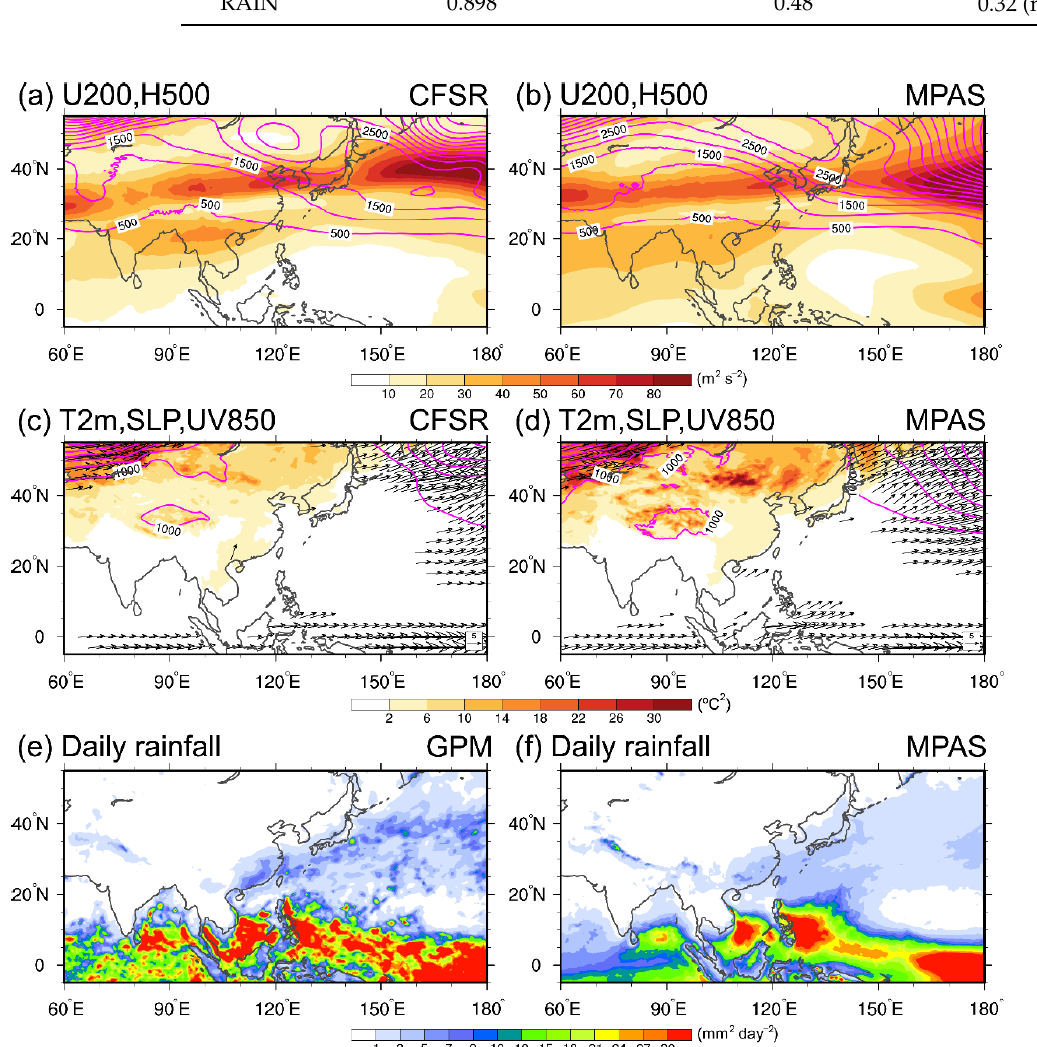
Figure 3. Same as Figure 2 but for the interannual DJF variances over 2011 – 2020 for ( a,b ) 200-hPa zonal wind (shaded) and 500-hPa geopotential height (contours), ( c,d ) 2-m temperature (shaded), sea-level pressure (contours), and 850-hPa winds (vectors), ( e,f ) daily rainfall (shaded). CFS reanalysis and GPM-retrieved rainfall (simulations) are listed at left (right) column.